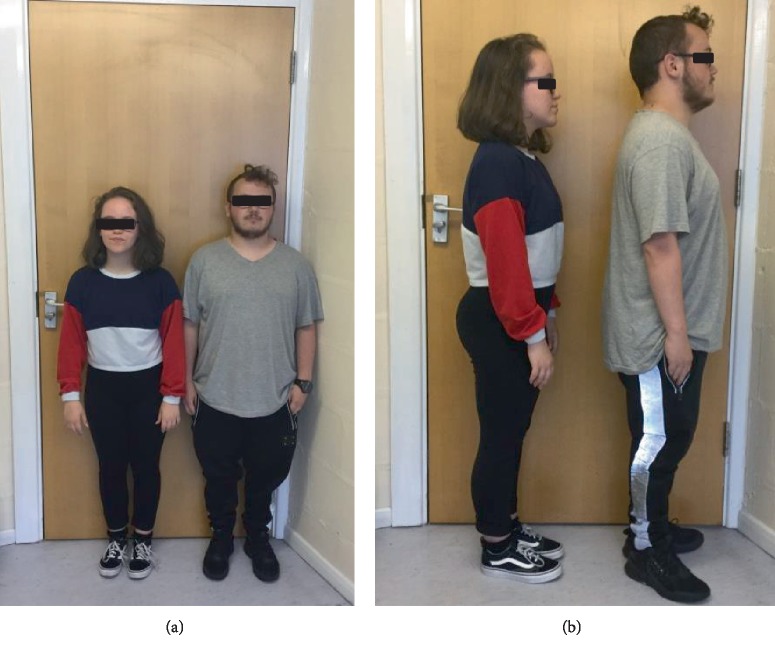
(a and b) A1 with her maternal half-brother, B1. Note significant short stature (both <0.4th centile). A1 has lumbar lordosis.